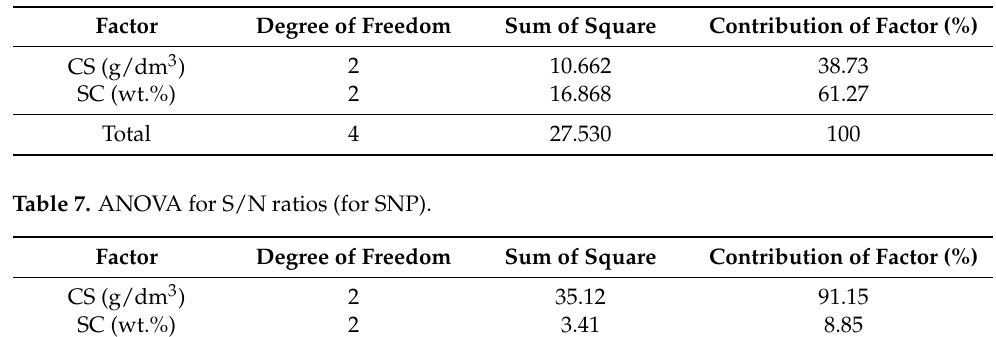
Table 6. ANOVA for S/N ratios (for APDP).